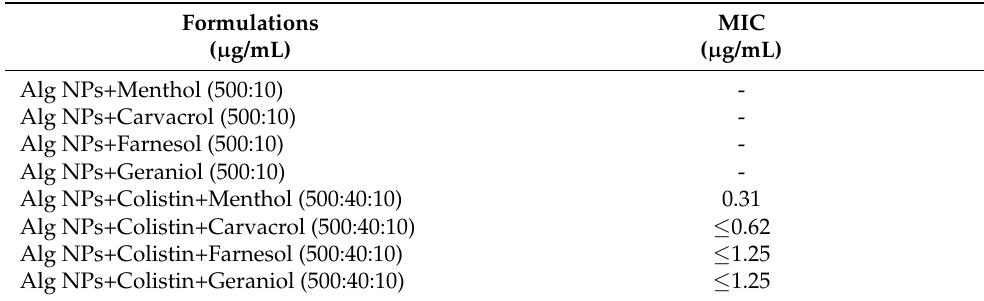
Table 2. MIC of colistin (in µ g/mL) alone and in combination with Alg NPs and components of essential oils against Escherichia coli 184